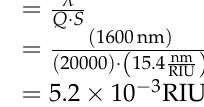
Figure 8. Simulated ( a ) wavelength shift and ( b ) RIU sensitivity vs. evanescent medium refractive index for cavities with TeO 2 coating thicknesses ranging from 0.5 to 1.1 μ m.